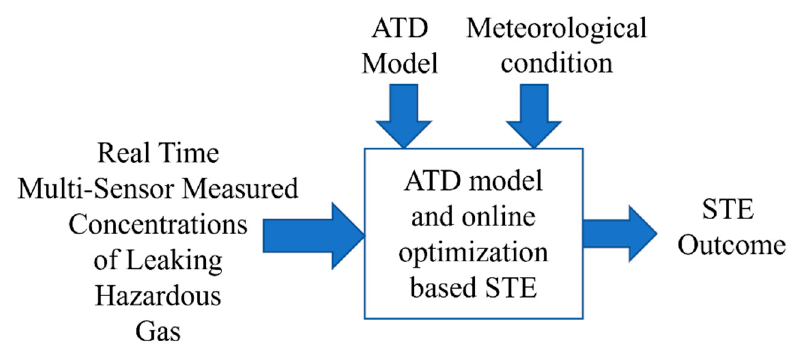
Figure 1. The basic idea of a conventional STE approach.